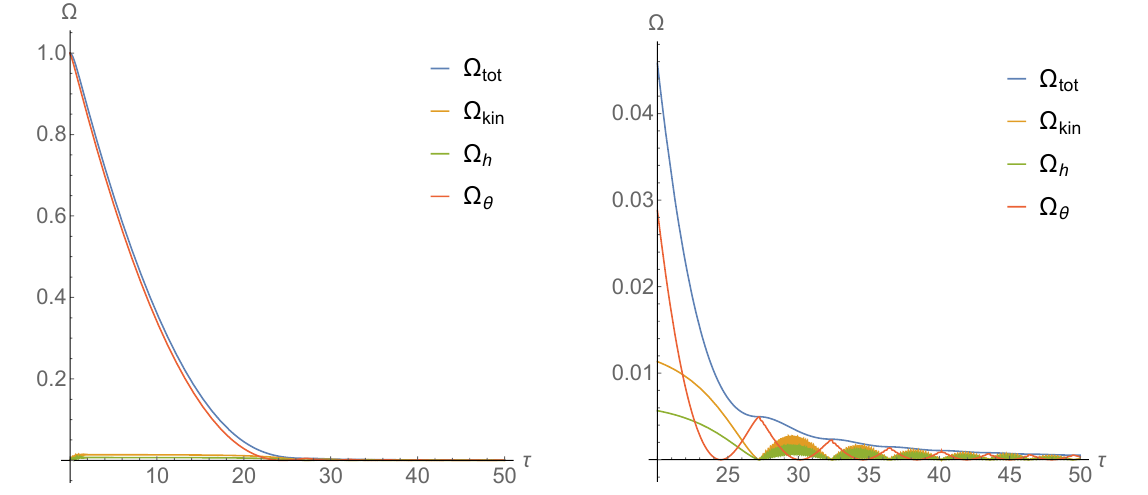
Figure 6 . Left-panel: the evolution of the density fraction (cid:10) i = (cid:26) i = (cid:3) 4 in the large-mixing case with h 0 = (cid:3) = 67. The right-panel shows the evolution from (cid:28) = 20 for the case with h 0 = (cid:3) =